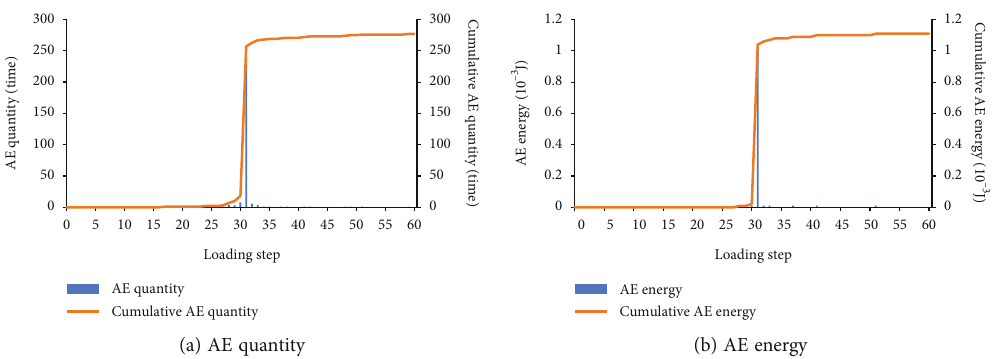
Figure 11: AE change curve when the distance a is